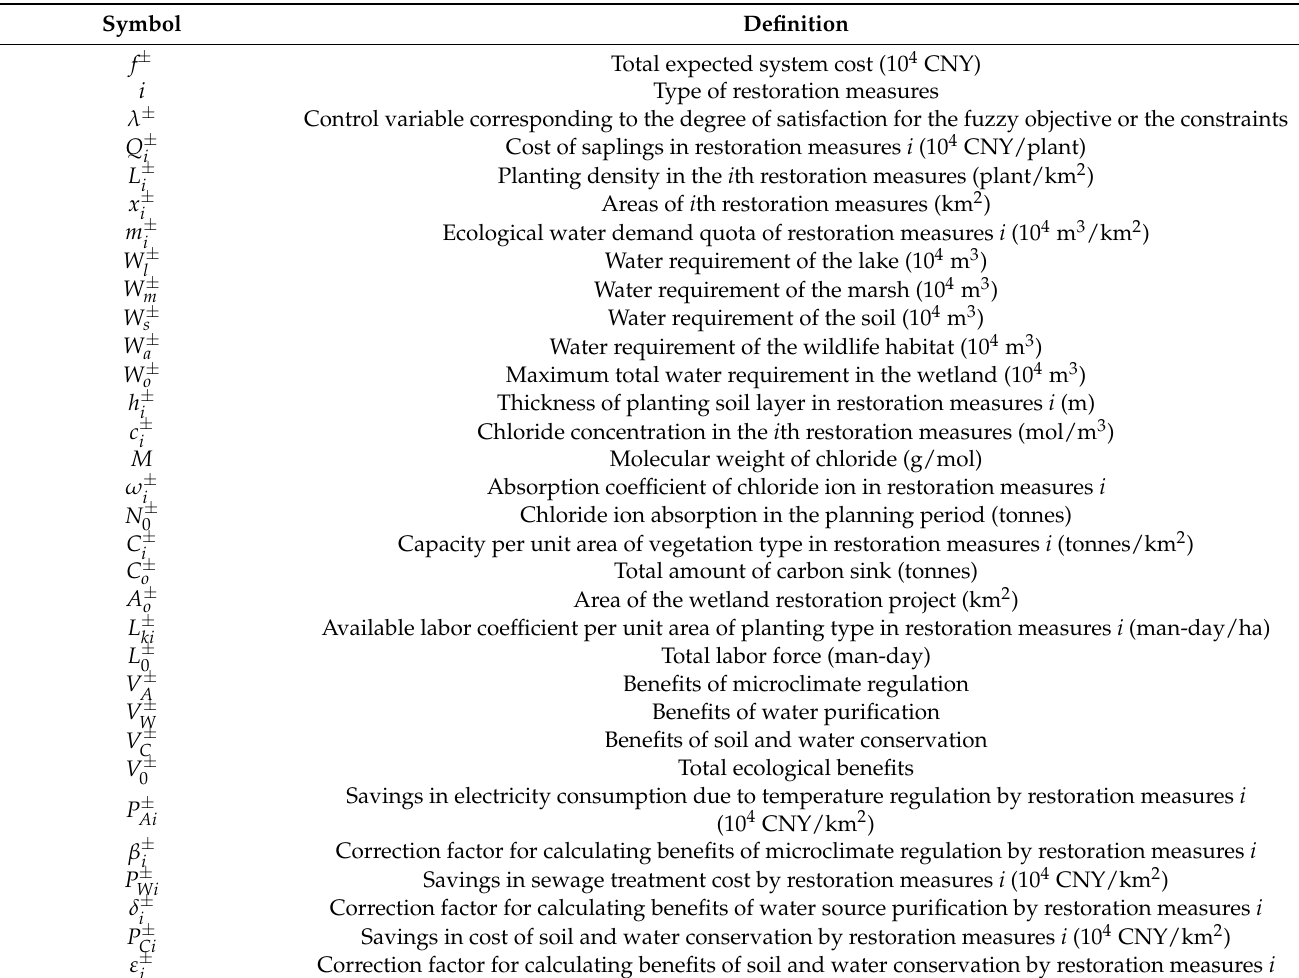
Table 1. Definitions of symbols in the IFLP